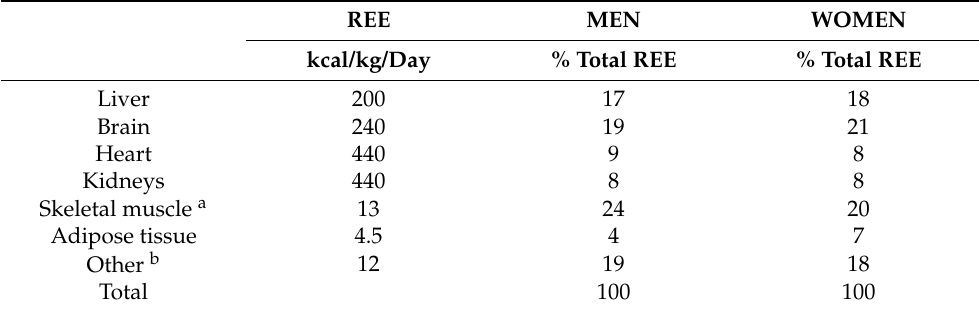
Table 2. Estimated metabolic rates of tissues and percentage contribution to total metabolism